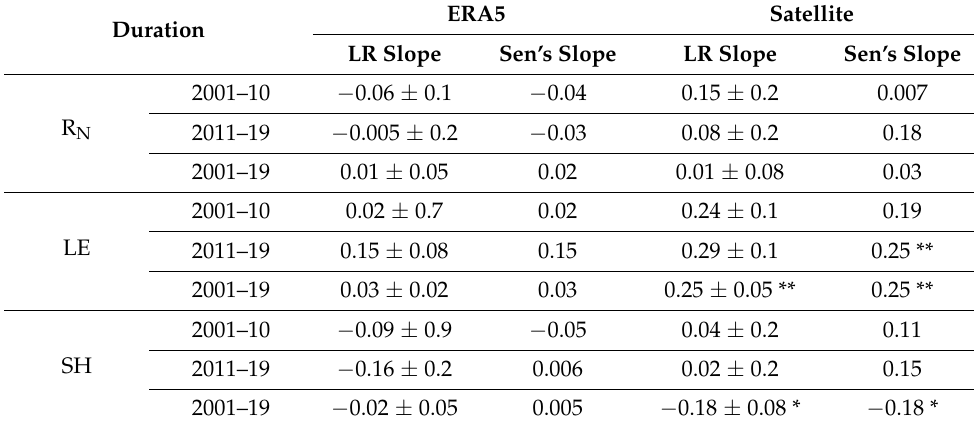
Table 4. Decadal and total temporal trends of R N , LE, and SH from ERA5 and satellite data sets. LR slope and Sen’s slope are used for temporal trend analysis. ** describe 99% significance while * describe 95% significance. The values after ± are standard errors in LR